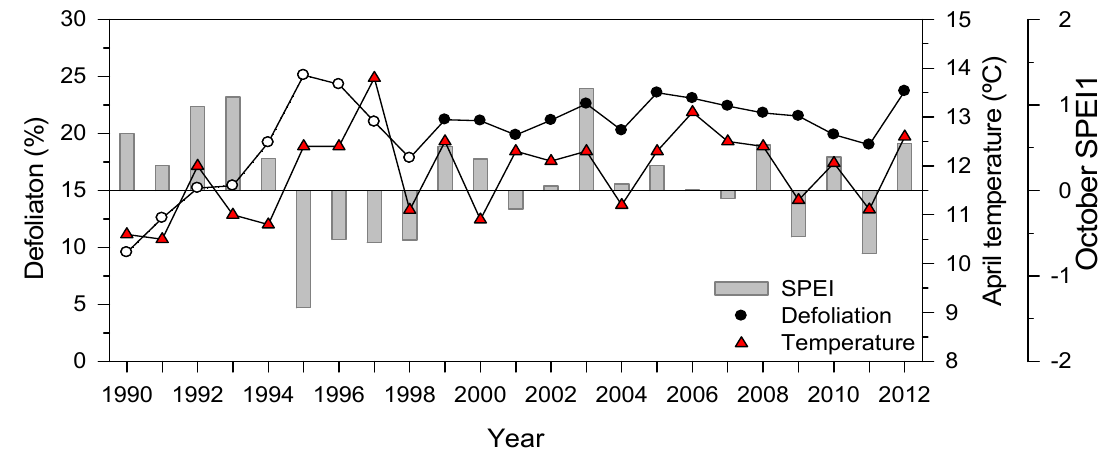
Figure 8. Defoliation levels (circles) of Spanish holm oak forests obtained for the period 1990–2012 as related to climatic variables (triangles, April temperatures; bars, October SPEI for one-month-long scales). The empty and filled circles of defoliation levels indicate two periods with different sample sizes: ca. 2400 (period 1990–1998) and ca. 3200 (period 1999–2012) trees,